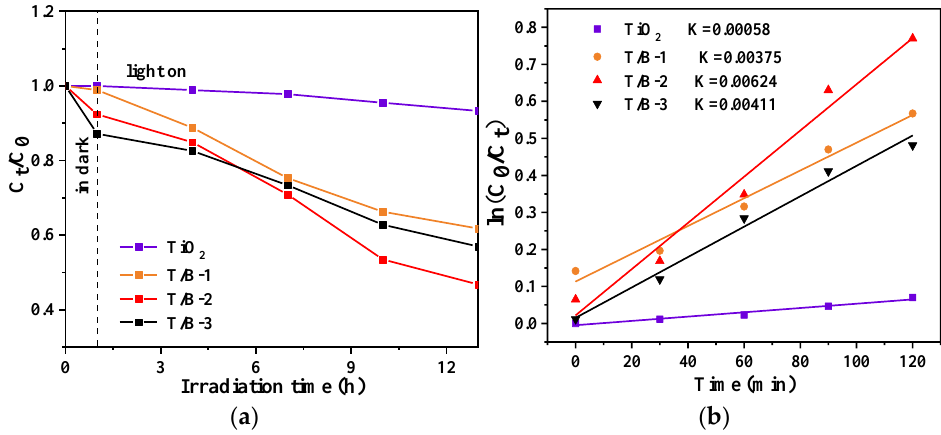
Figure 10. ( a ) Photocatalytic degradation efficiency of methyl orange by different fibers, ( b ) first-order kinetics of photodegradation of methyl orange.